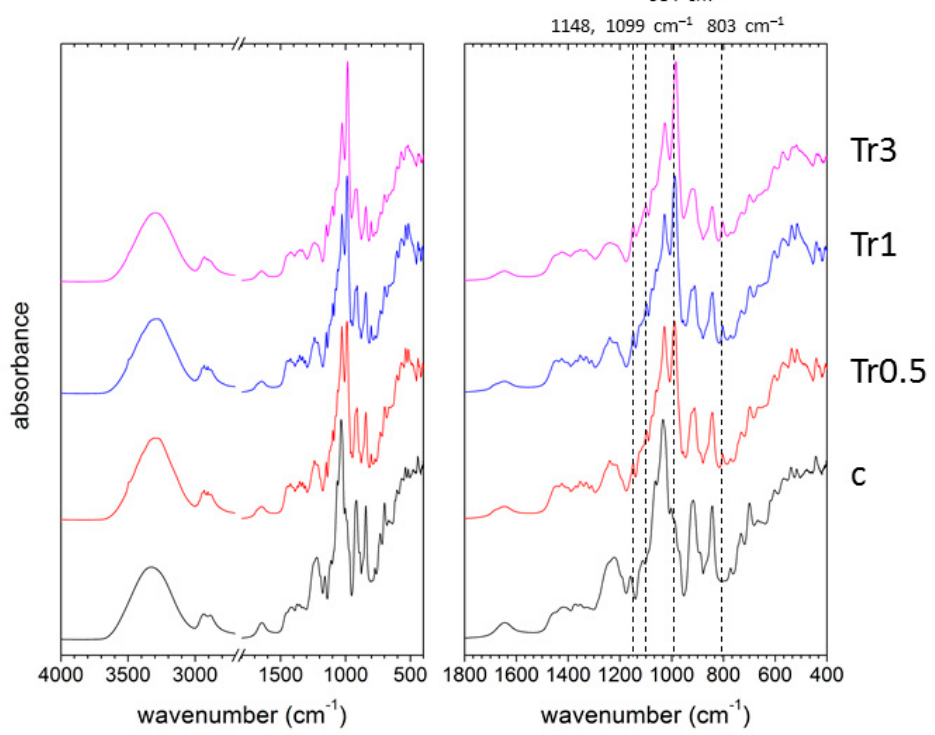
Figure 7. ATR FTIR spectra of the trehalose-containing carrageenan films without the addition of essential oil (0.5 g of carrageenan).